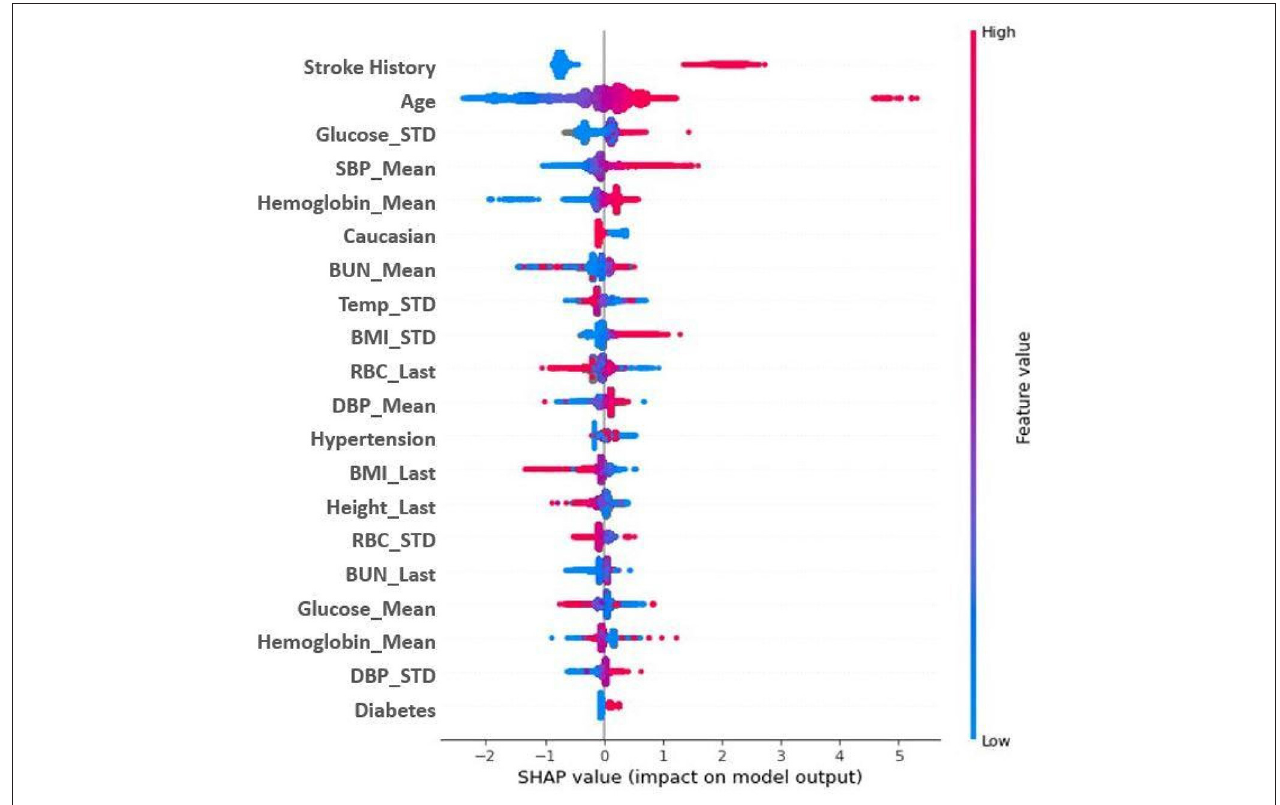
FIGURE 4 | SHAP Plot for model feature importance. Features are ranked in descending order of importance as measured by SHAP values. Red indicates a high feature value; blue indicates a low feature value. Dots to the right are indicative of a higher score; dots to the left a lower score. Mean and STD represent average and standard deviation, respectively. BMI, body mass index; BUN, blood urea nitrogen; CHF, congestive heart failure; DBP, diastolic blood pressure; RBC, red blood cells; SBP, systolic blood pressure; TEMP: